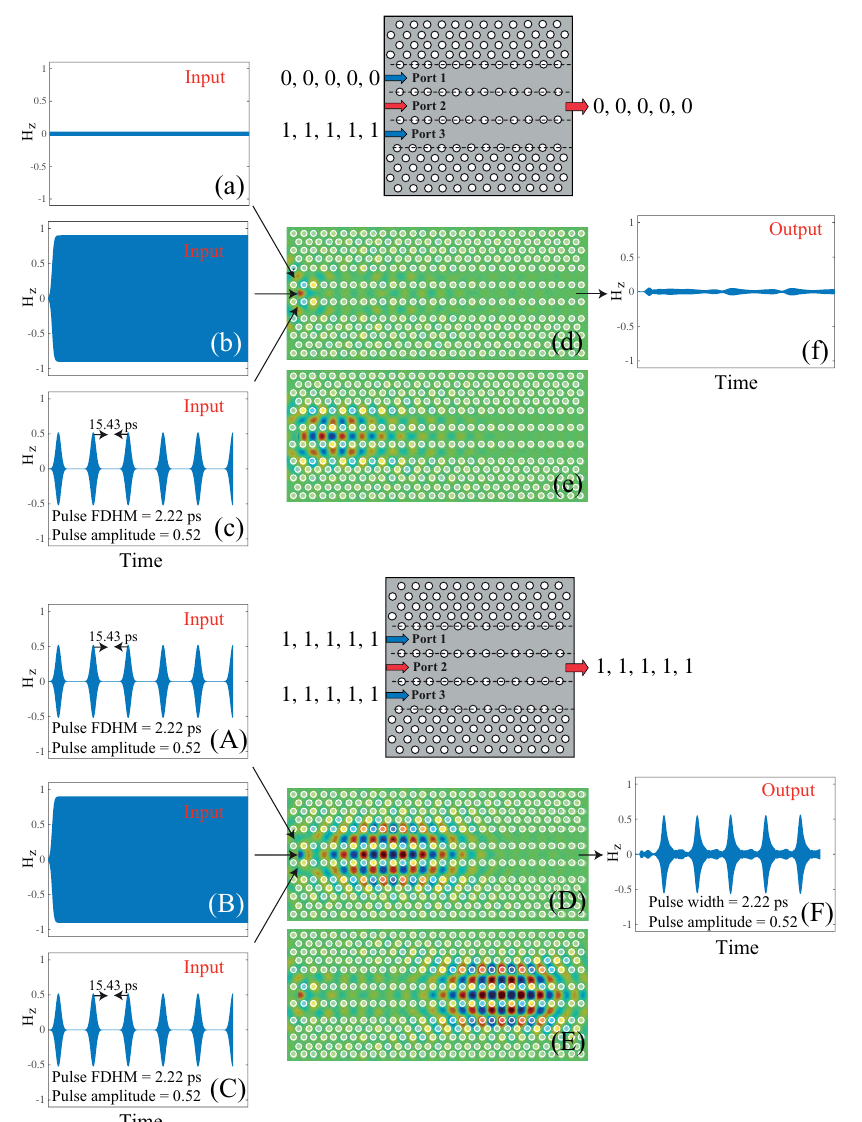
Figure 6. Realization of a functional all-optical AND logic gate: the upper and lower set of graphs represent different scenarios of injection of the input signals into Port 1. Upper graph: ( a ) no signal is injected into Port 1; ( b ) a CW signal is injected into Port 2; ( c ) a train of five Gaussian pulses is launched into Port 3; ( d ) and ( e ) magnetic field distributions inside the C-PCWs at different moments; ( f ) magnetic field H z of the received signal at a distance x = 30 h associated with Port 2. Lower graph: ( A ) a train of five Gaussian pulses is launched into Port 3; ( B ) a CW signal is injected into Port 2; ( C ) a train of five Gaussian pulses is launched into Port 3; ( D ) and ( E ) magnetic field distributions of the signal pulses; ( F ) magnetic field H z of the received signal. The peak level contrast between “1” and “0” amounts to 20 dB. Reprinted from Ref.